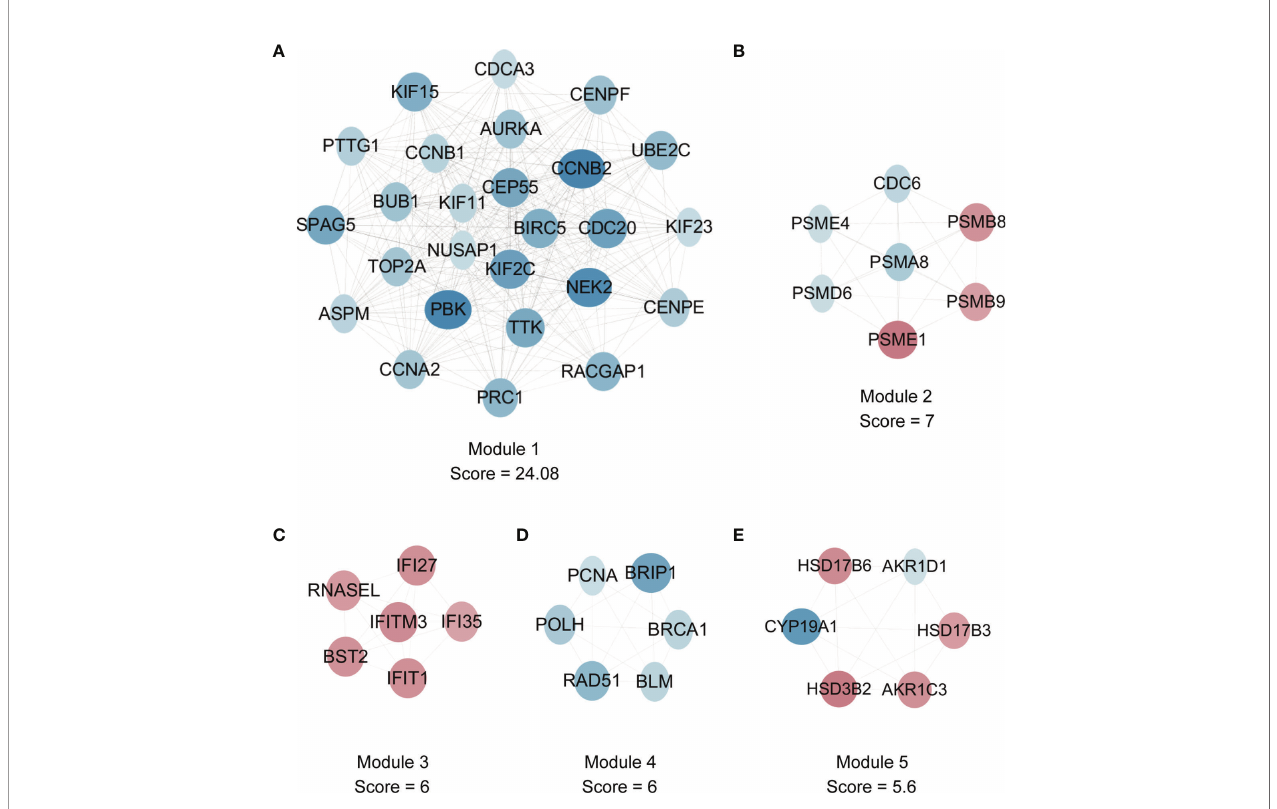
FIGURE 5 | The detection of hub modules in PPI network. (A) There are 26 nodes and 301 edges in module 1. (B) There are 7 nodes and 21 edges in module 2. (C) There are 6 nodes and 15 edges in module 3. (D) There are 6 nodes and 15 edges in module 4. (E) There are 6 nodes and 14 edges in module 5. Red and blue nodes represent gene expression levels corresponding to upregulated and downregulated expression. DEGs, differentially expressed genes; PPI, protein-protein